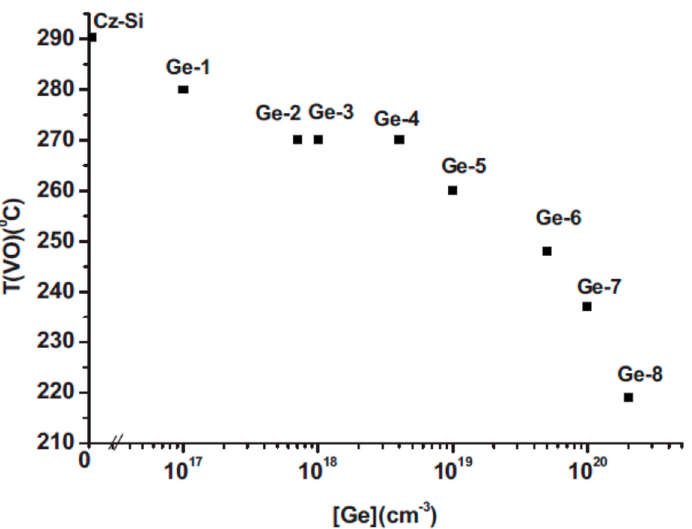
Figure 7. Annealing temperature of VO defects as a function of Ge dopant concentration. Reproduced with permission from [128]. American Institute of Physics, 2010.